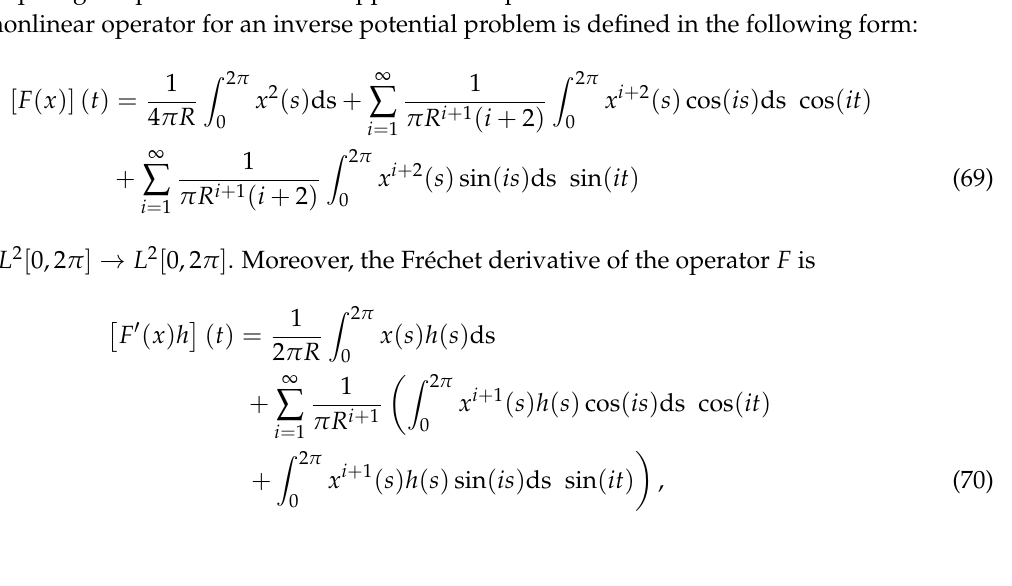
2. Figure 3. Graph of y = N − 1/2 ( ln N ) p for 1 p p ≤ ≤ ≤ ≤